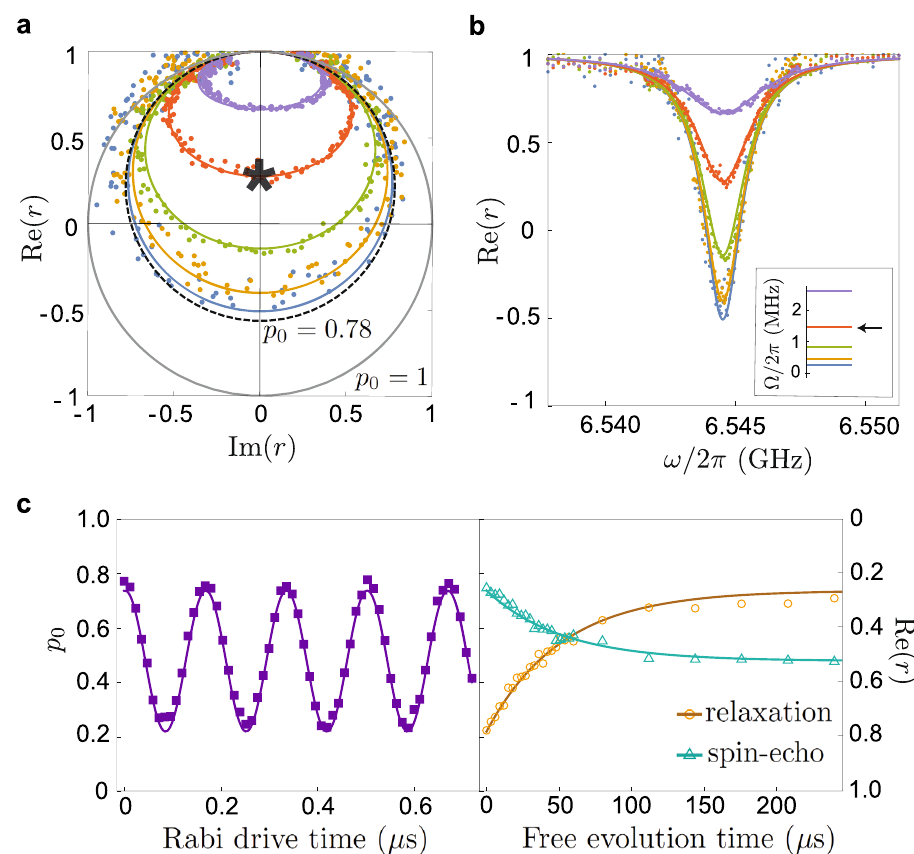
Fig. 2 Conditional fl uorescence readout. a Complex plane representation and b real part of the re fl ection coef fi cient r as a function of readout drive frequency ω at various powers represented by the 0 j i (cid:2) 3 j i transition Rabi frequency Ω (inset). The experimental data (colored dots) are fi tted by the theory of Eq. (1) (lines) with Γ = 2 π × 1.74 MHz and p 0 = 0.78 due to the thermal occupation of excited states. In the limit Ω → 0, the data in Fig. 2a becomes a circle with a radius p 0 (gray circle, p 0 = 1 and dashed circle, p 0 = 0.78). The optimal readout settings are highlighted by the black star and arrow (see text below Eq. (1)). c Rabi oscillations (left panel), energy relaxation (right panel, yellow circles), and spin-echo coherence decay (green triangles) were measured using conditional fl uorescence readout at optimal settings. Fitting to exponential decay yields (coincidentally) T 1 = T 2 = 52 μ